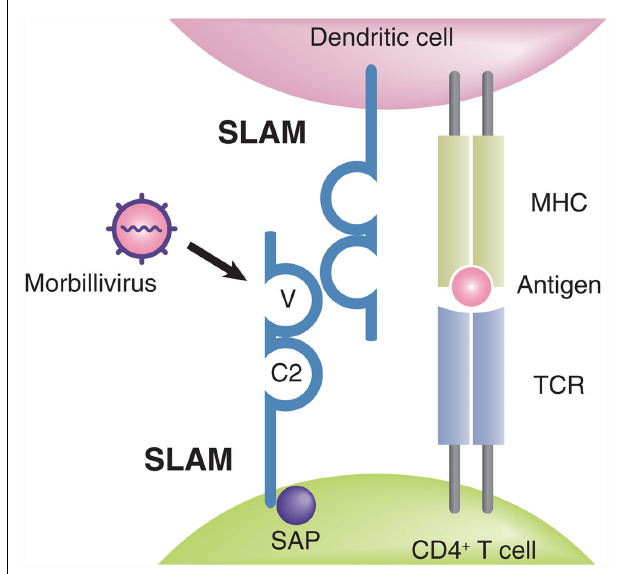
FIGURE 3 | Structure of SLAM. The SLAM extracellular domain is composed of a variable (V) and a constant (C2) Ig-like repeat. SLAM interacts with another SLAM on an adjacent cell. All morbilliviruses bind to theV domain of